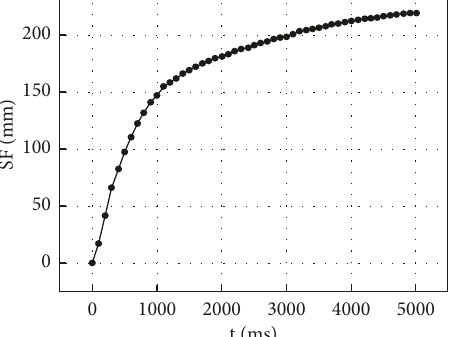
Figure 8: The SF-T curve.